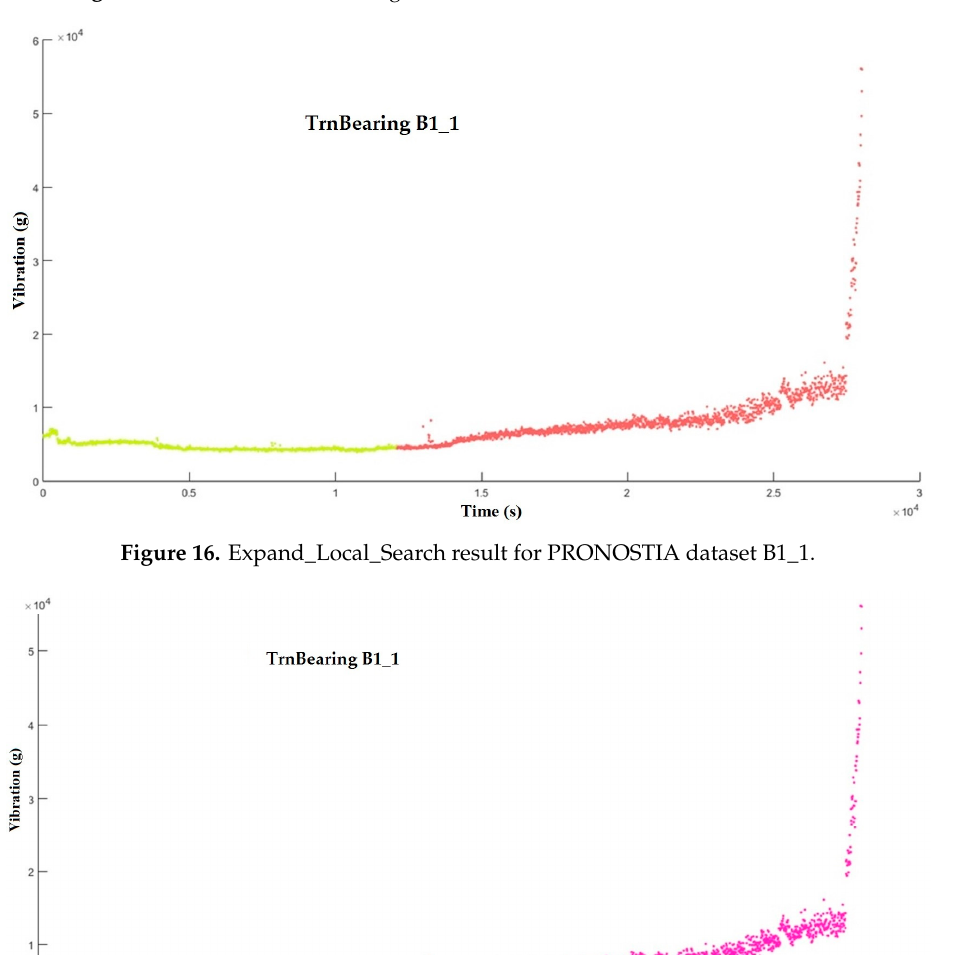
Figure 15. CMO initial solution generation result for PRONOSTIA dataset B1_1.